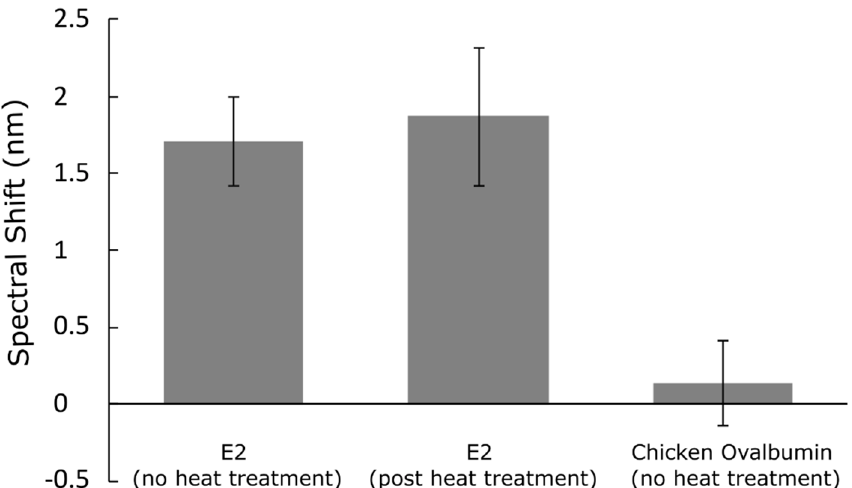
Figure 6. Detection of E2 protein after exposure to high-temperature environment. Comparison of spectral resonance shift of PSi sensor after capture of E2 protein under normal conditions (i.e., without exposure to elevated temperature) and after the PSi sensor was exposed to high temperature (90 ◦ C) immediately prior to incubation in the E2 protein solution. Similar magnitude redshifts (1.7 ± 0.3 nm compared to 1.9 ± 0.5 nm, N = 4) are observed for both conditions, which demonstrates the robustness, stability, and preserved biofunctionality of the peptide capture agents in harsh conditions. In contrast, a negligible spectral shift (0.1 ± 0.3 nm, N = 4) is observed after the control solution of chicken ovalbumin is exposed to the PSi sensor, confirming the specificity of the E2-binding peptide.